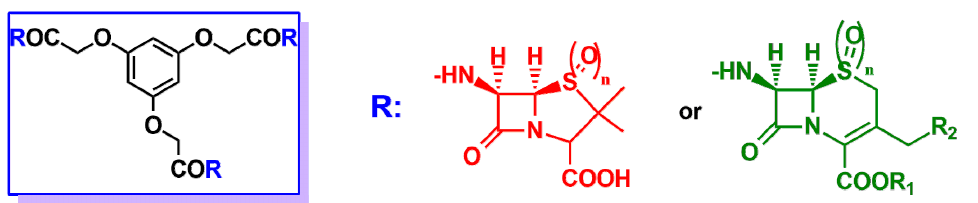
Figure 6. In the blue rectangle on the left, general structure of the β -lactam podand derivatives described in Refs. [24,25]. R may be either the 6-APA nucleus (red) or the 7-ACA nucleus (green), when n = 0, or the sulphone derivatives of 6-APA or 7-ACA when n = 2.